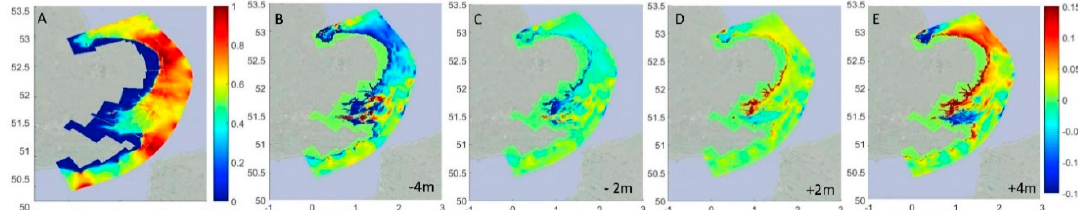
Figure 8. ( A ) residual currents during spring tide; ( B – E ) changes in residual currents associated with different sea level variations. Sea level variations range from − 4 m (panel E ) to 4 m (panel E ). Results are presented for the highest spring tide of the study period (11 February